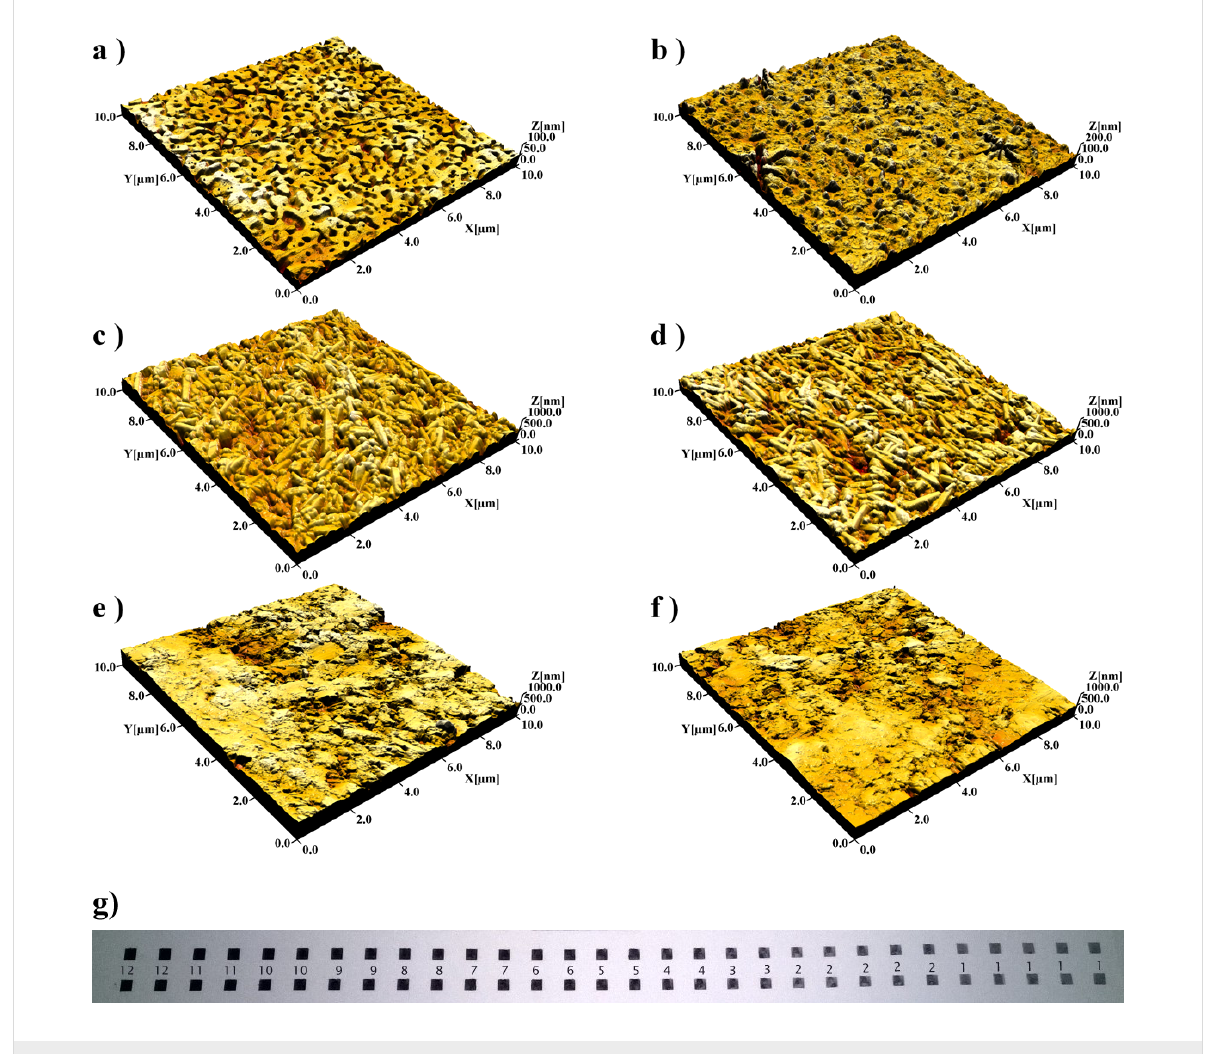
Figure 1: AFM topographical images (10 µm ×10 µm) of paper substrates with (left side) and without (right side) printed GNS patterns (10201 drops/mm 2 , 1 layer). The substrates are as follows: (a,b) non-permeable paper substrate; (c,d) semi-permeable paper substrate with barrier layer and (e,f) permeable paper substrate with no barrier layer. A photograph of the printed GNS patterns (4578 drops/mm 2 , 1–12 layers) on the non- permeable paper substrate is shown in panel